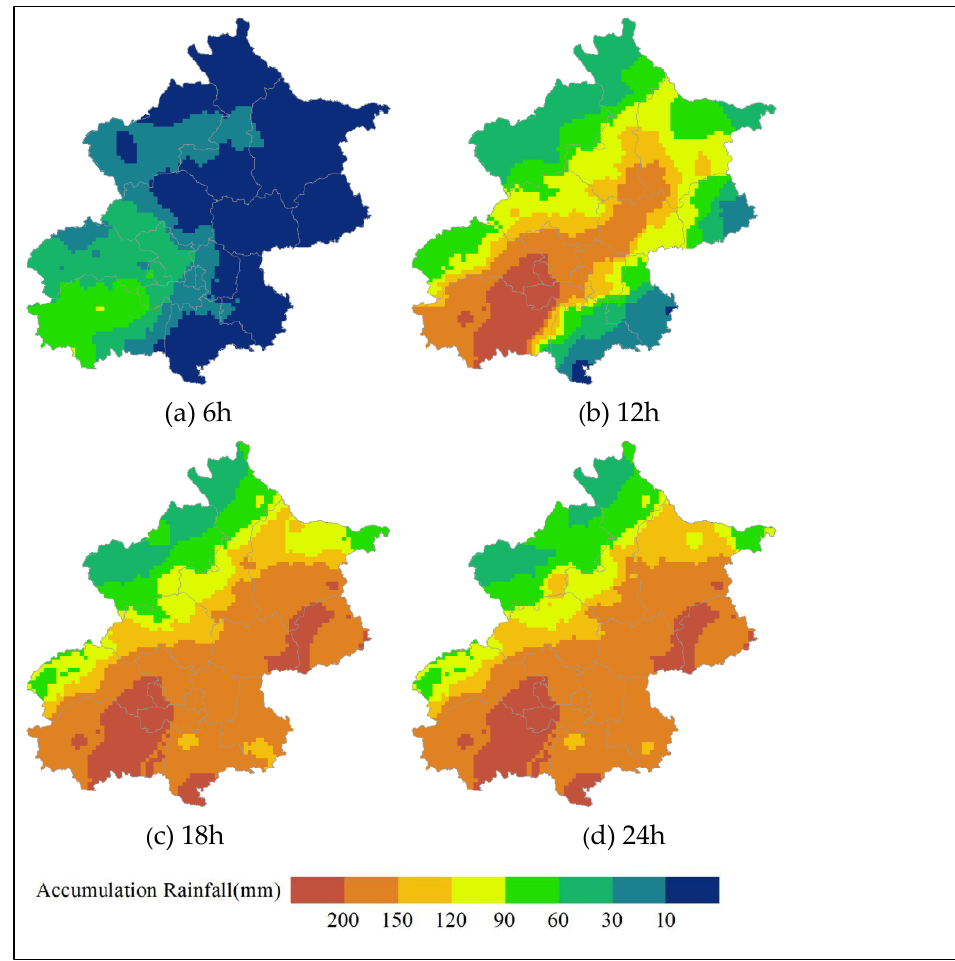
Figure 5. Rainfall accumulation of rainstorm occurred on 21 July 2012 in Beijing.